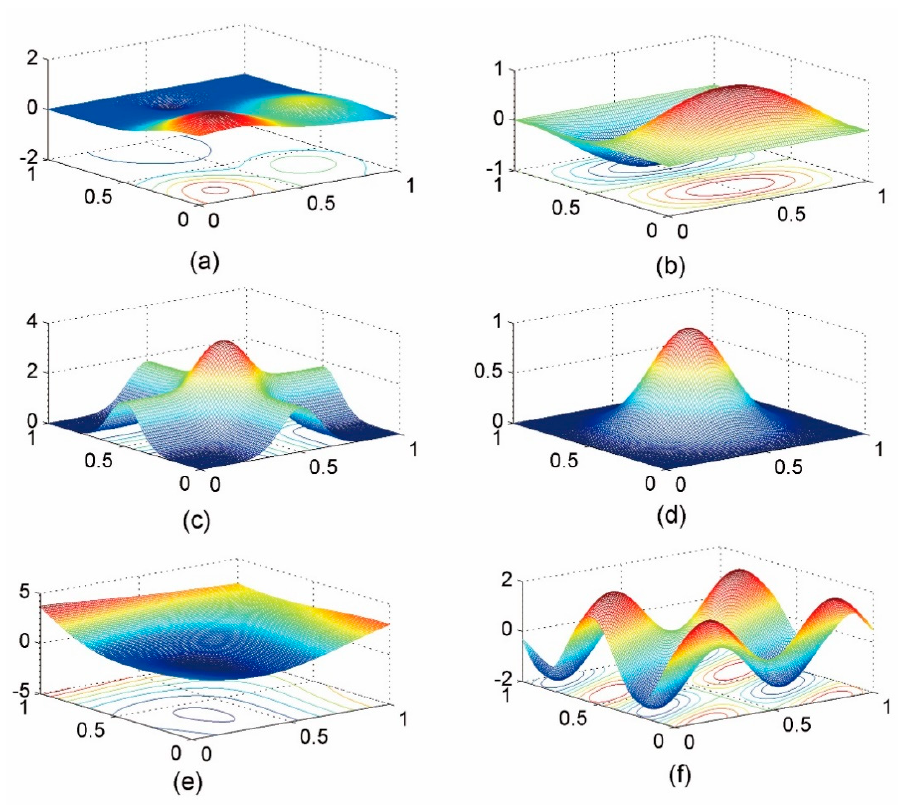
Figure 3. The six synthetic surfaces: ( a ) f 1 (x,y), ( b ) f 2 (x,y), ( c ) f 3 (x,y), ( d ) f 4 (x,y), ( e ) f 5 (x,y), and ( f ) f 6